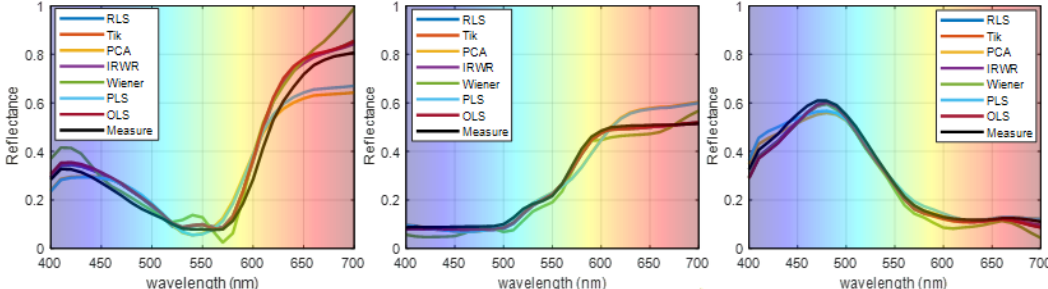
Figure 8. Representative samples of reconstructed spectra of the proposed method and the traditional methods.